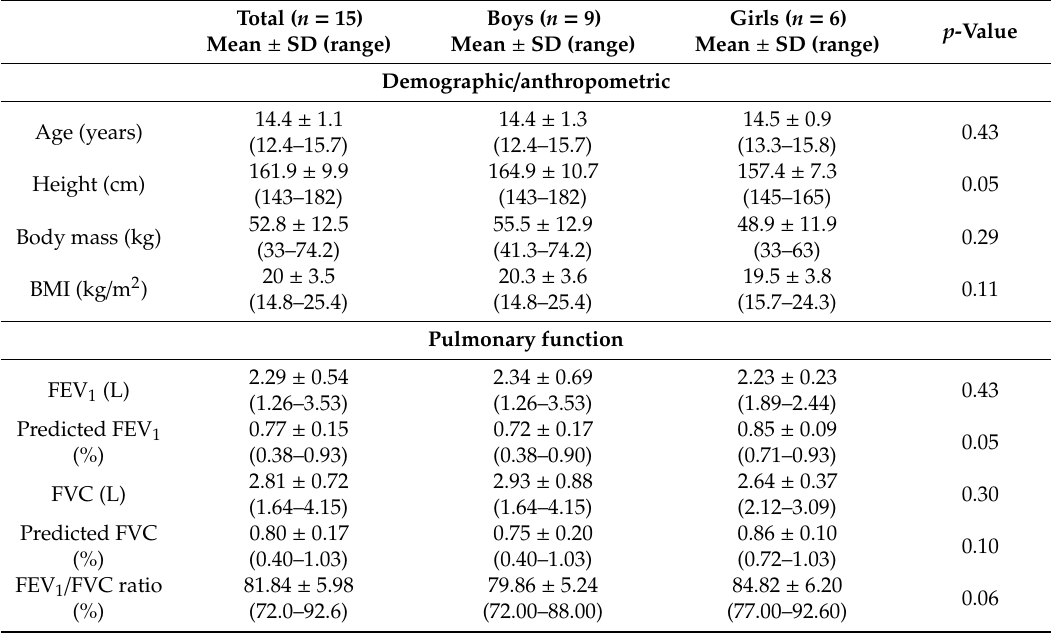
Table 1. Demographic, anthropometric,